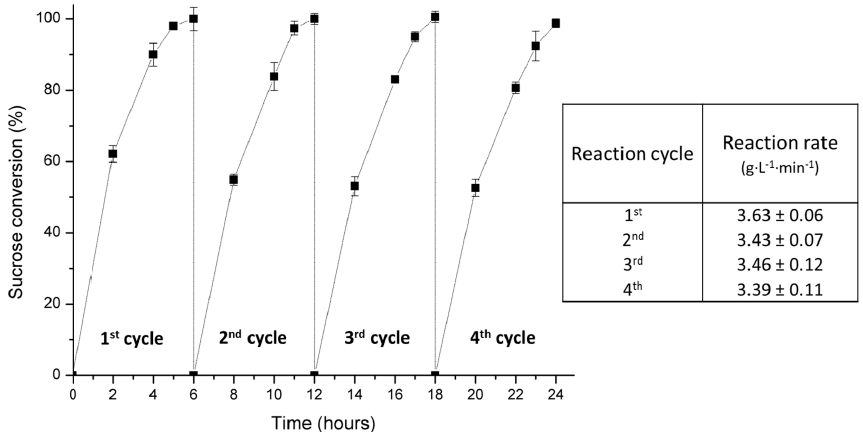
Figure 3. Conversion profiles and corresponding reaction rates of the immobilized invertase. Data represent four consecutive reaction cycles. Five milliliters sucrose solution (5.0% ( w / v ) at pH 4.5) was fed to the microchannel reactor in recirculation mode at a flow rate of 3.50 mL · min − 1 . Runs were performed at 50 ◦ C. At the beginning of each cycle, fresh substrate solution was added. Experiments were performed in triplicates and error bars represent the standard